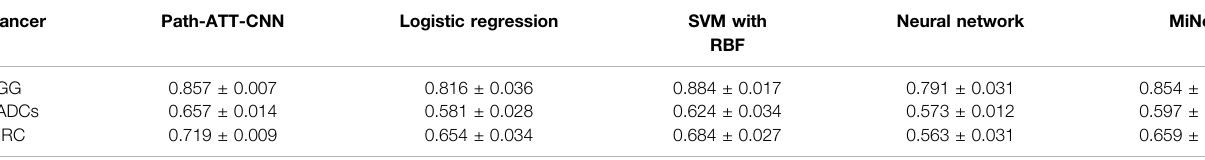
TABLE 1 | Comparison of predictive performance.